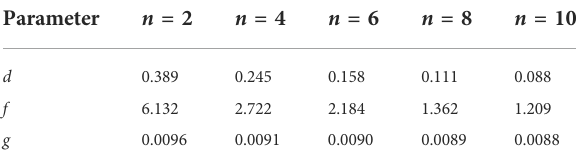
TABLE 8 Values of parameters d, f, and g.